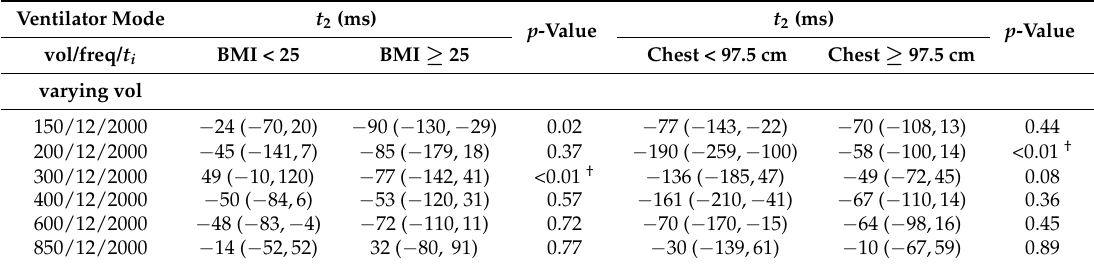
Table 2. Median time differences with 95% CI between Paw EO and TTI maximum downslope for normoweight patients (BMI < 25, 12 patients) and overweight patients (BMI ≥ 25, nine patients). There were no significant differences (at the 0.01 level) between normoweight and overweight patients except at three ventilator settings (indicated by † ) with no discernible